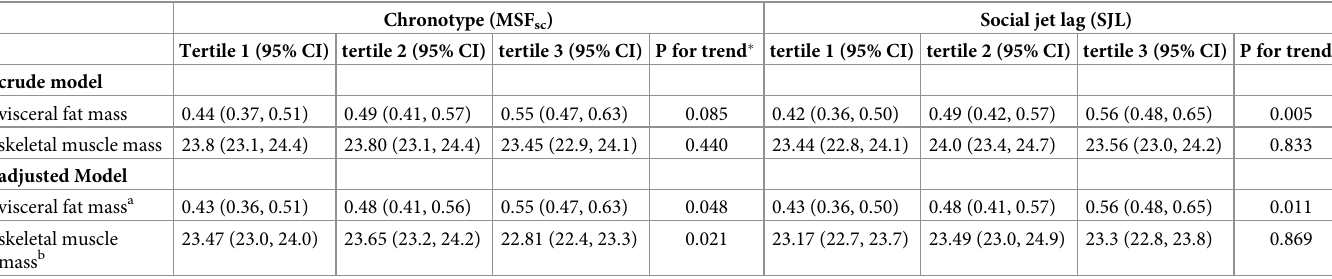
Table 2. Multivariable regression analysis of the association of chronotype/social jet lag with visceral fat/skeletal muscle mass mass (kg).